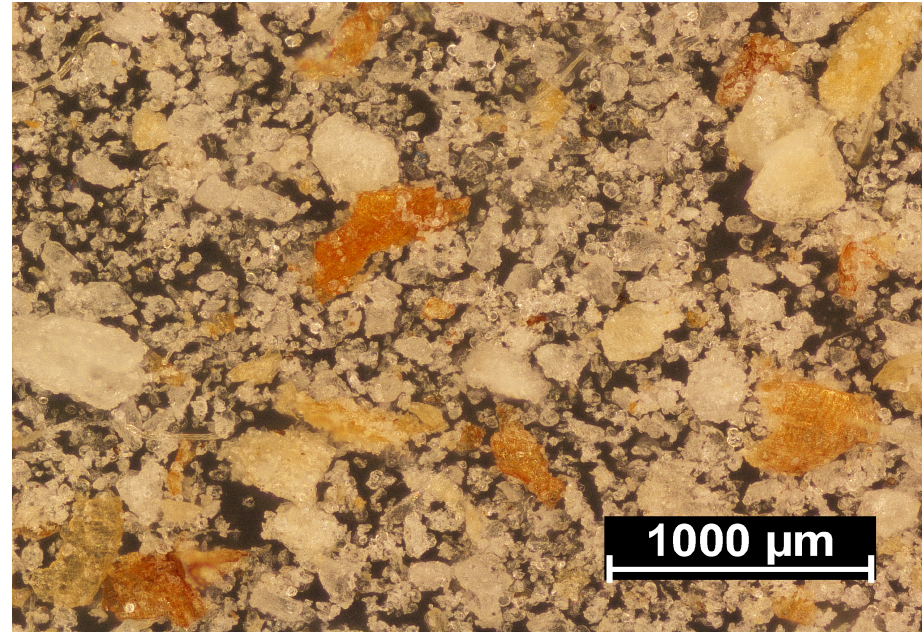
Figure 10. Microscopic image of the applied filler. Microscopic images of PBS pellets and composite pellets obtained at a screw rotational speed of 125 min − 1 are shown in Figure 11. The observed cross-section of PBS pellets provided by the manufacturer (Figure 11a) does not indicate any defects, with the pellets being white. The photos showing pellets with a bran content of 10 wt.% (Figure 11b), 30 wt.% (Figure 11c) and 50 wt.% (Figure 11d), however, indicate numerous defects in the form of pores. The cause behind their formation was the presence of structurally-bound water in the filler particles. This expanded after leaving the extrusion head and meeting the reduction in atmospheric pressure. In this situation, the greater the WB content, the higher the pore quantity. Figure 11b shows individual pores of regular shape, located solely near the pellet center. This is associated with the small amount of bran and rapid crystallization of the outer material layer when cooled within the water bath. In the case of higher WB content (Figure 11c,d), the pore count increases, and these interconnect into larger, irregular voids that appear near the pellet edge. Still, a uniform distribution of the filler was found in all cases, and WB particles were observed both within the material